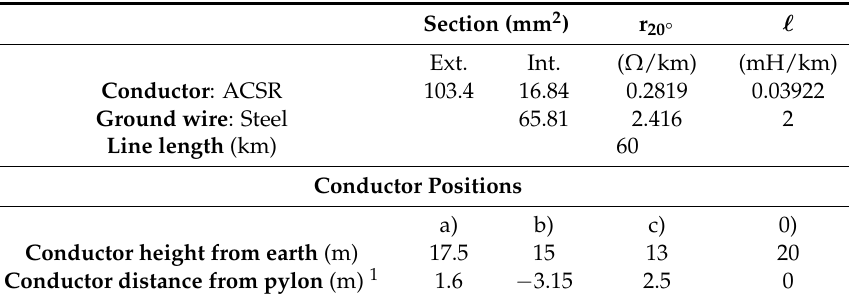
Table 1. Electrical Parameters and Position of Conductors in the Case Study.